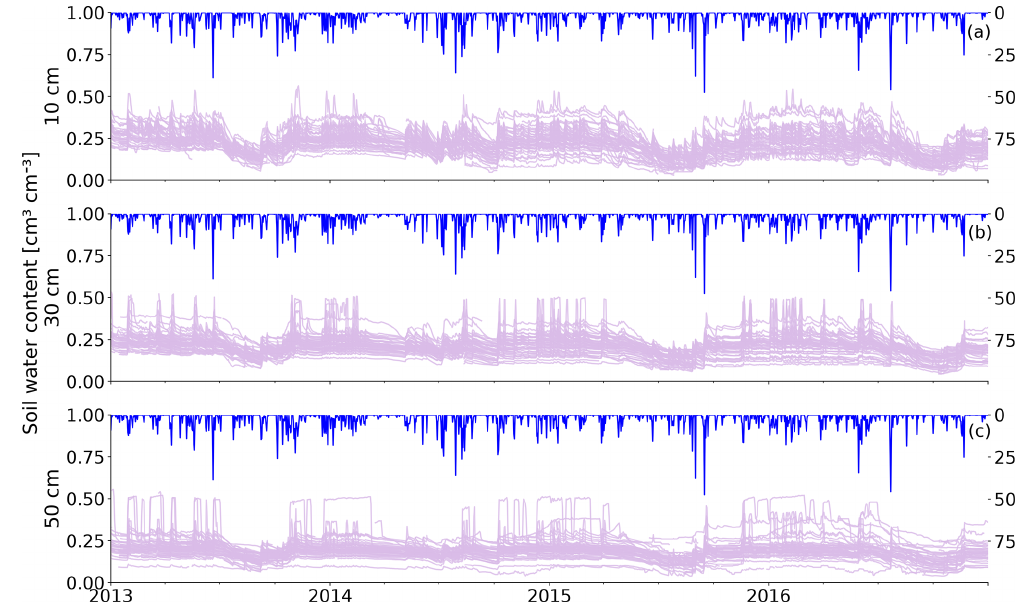
Figure 2. Soil moisture data overview. Soil moisture observations in 10cm (a) , 30cm (b) and 50cm (c) .